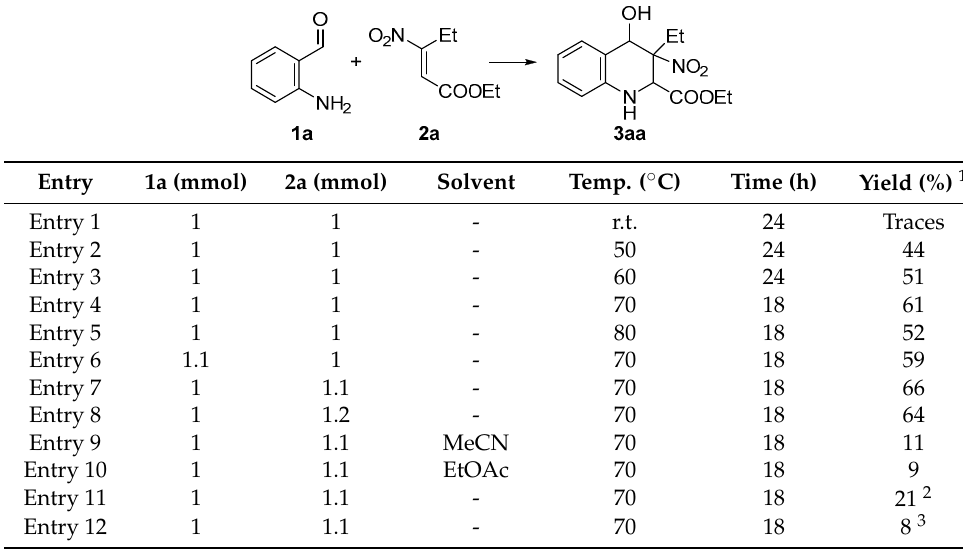
Table 1. Optimization studies concerning the “ aza -Michael-Henry domino process”.